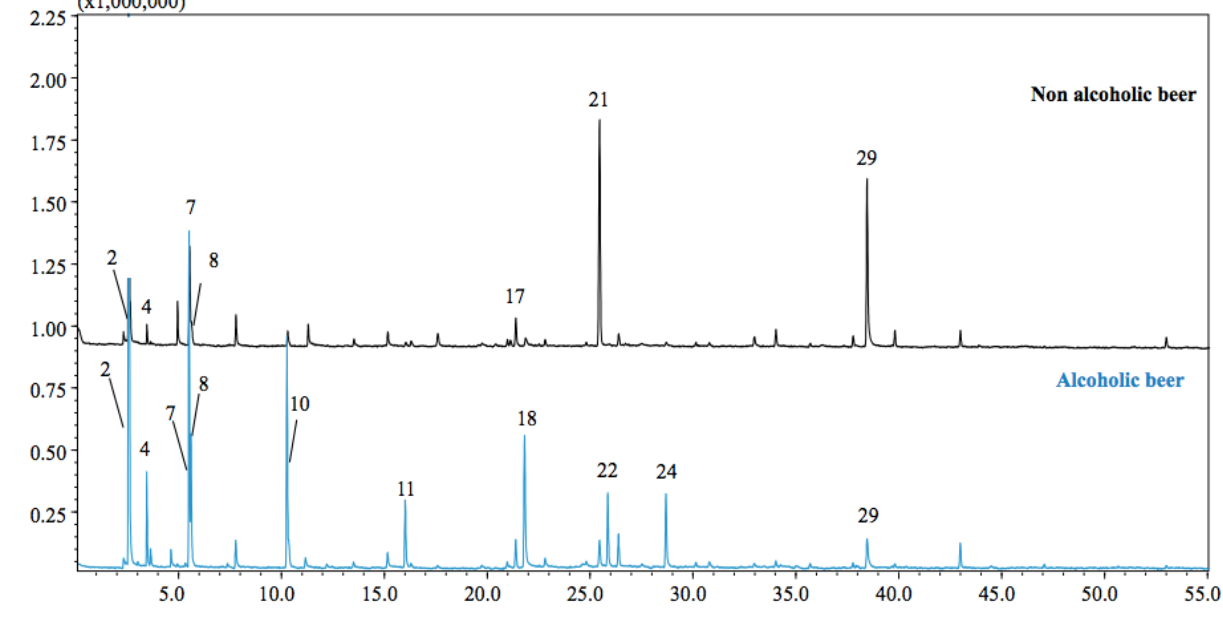
Figure 2. GC – MS chromatograms of alcoholic and non-alcoholic beer samples . Figure 2. GC–MS chromatograms of alcoholic and non-alcoholic beer samples.